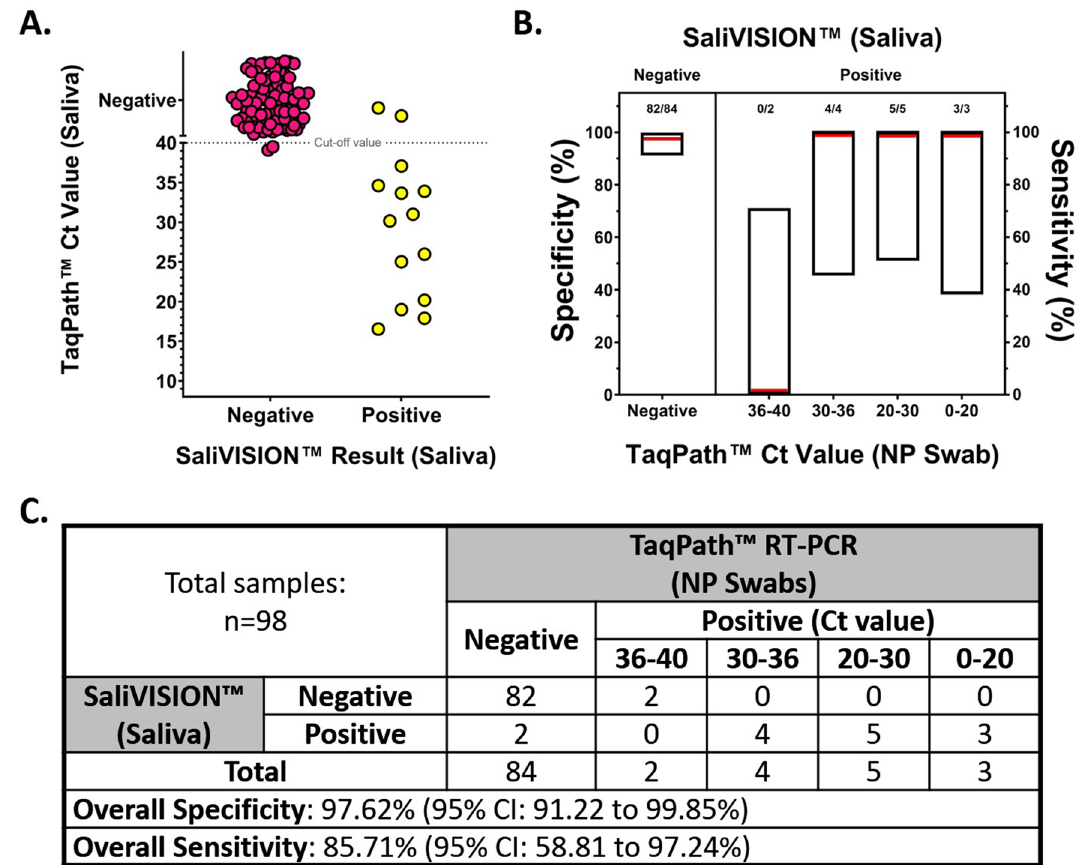
Figure 5. Clinical Validation of SaliVISION, Tested Side-by-Side with TaqPath, Using Saliva and Nasopharyngeal Swab Samples. Pairs of saliva and nasopharyngeal (NP) swab samples being collected from the study participants were subjected to SARS-CoV-2 detection using SaliVISION (RT-LAMP) and Thermo Fisher Scientific TaqPath (RT-qPCR) methods, respectively. For SaliVISION test, saliva samples were treated with the lysis buffer and heat-inactivated before being processed as described previously. This test was performed on-site immediately after the collection. The NP swab samples were processed according to standard protocol as described previously in the following day. The results of RT-LAMP are compared to relative Ct value determined by quantitative RT-PCR TaqPath test. ( A ) The figure represents the distribution of negative (pink) and positive (yellow) samples detected by the SaliVISION test according to their corresponding Ct value detected by the TaqPath test (Y axis). The dotted line indicates the cut-off value for TaqPath test, in which the samples with Ct value > 40 is considered negative and that with Ct value ≤ 40 is considered positive. ( B ) Specificity (left) and sensitivity (right) of the SaliVISION RT-LAMP assay, derived from data in 4A and C, are shown. For sensitivity, the RT-qPCR positive samples were stratified into four groups, based on the Ct value (x axis). The red lines indicate the value of these proportions. The floating boxes indicate the corresponding 95% confidence